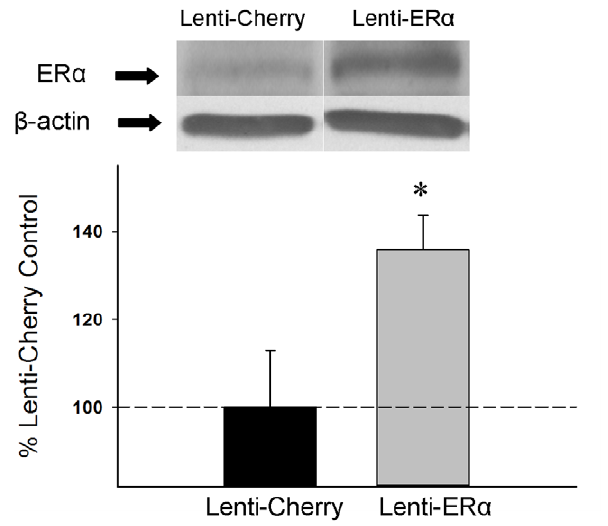
Figure 5. Effects of lenti-viral delivery to the hippocampus of the gene encoding ER a (Lenti-ER a ) or a control virus (Lenti- Cherry) to aging ovariectomized rats on protein expression of ER a in the hippocampus as measured by western blotting. Mean density x area ( + SEM) expressed relative to Lenti-Cherry control. * P=.03 vs. Lenti-Cherry. Representative blot images for ER a and the loading control b -actin are shown in insets above the graph.